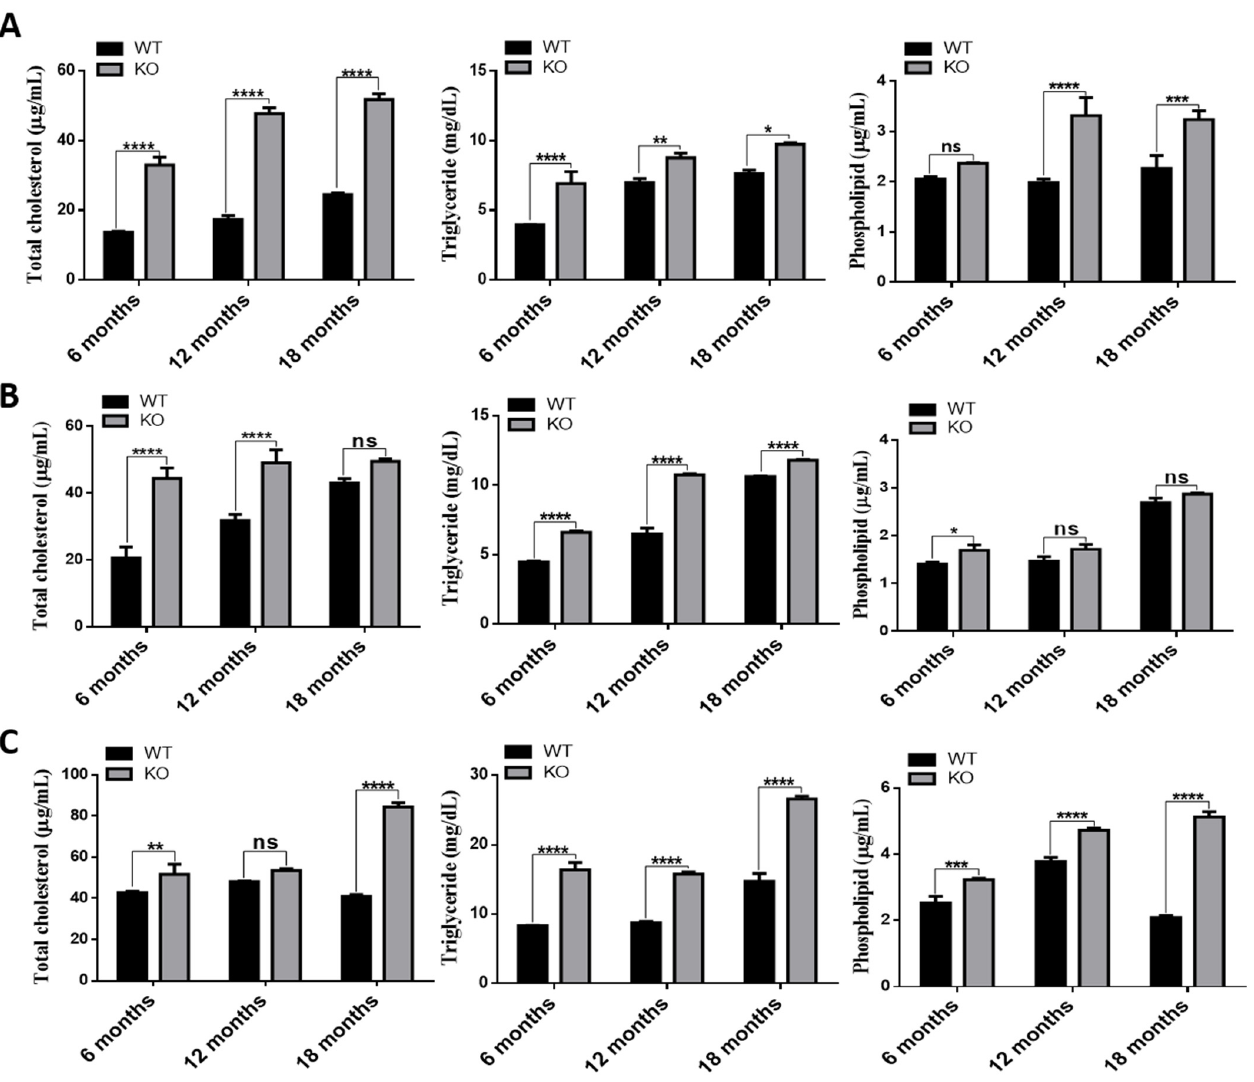
Figure 3. Total cholesterol, Triglycerides and phospholipids in RPE/choroid/sclera ( A ), retina ( B ) and brain ( C ) brain of wildtype and Tspo KO mice (6, 12 and 18 months old) were measured and normalized to total protein contents. Data were collected from three independent experiments and analyzed by two-way ANOVA followed by Bonferroni test. NS: no significance; * p < 0.05, ** p < 0.01, *** p < 0.001, **** p < 0.0001.